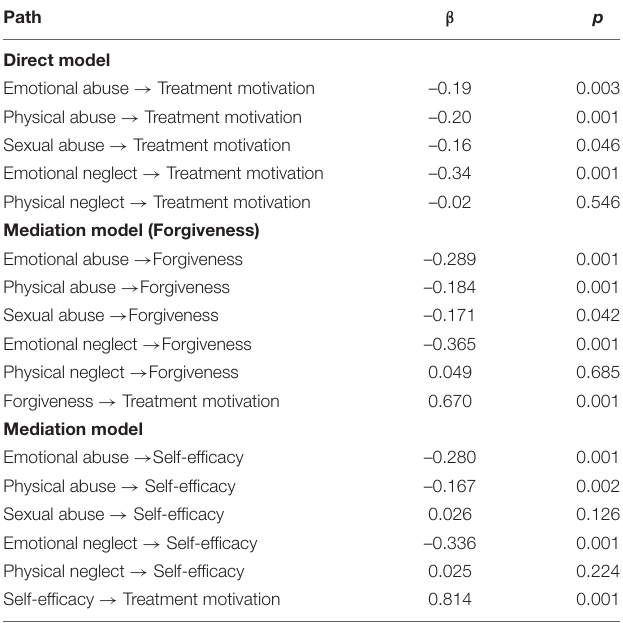
TABLE 5 | Results of mediation effect of forgiveness and self-efficacy on various forms of maltreatment and treatment motivation. Path β